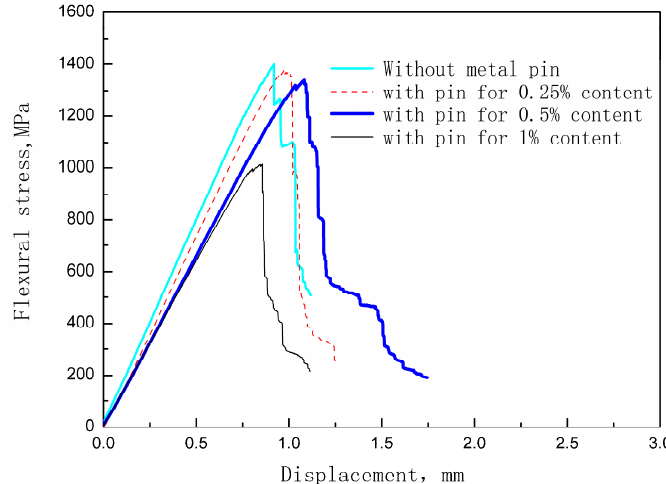
Figure 5. Typical Cf/Al stress-deflection results for samples without a z-pin and those with varying z-pin contents and a 0.3 mm diameter.